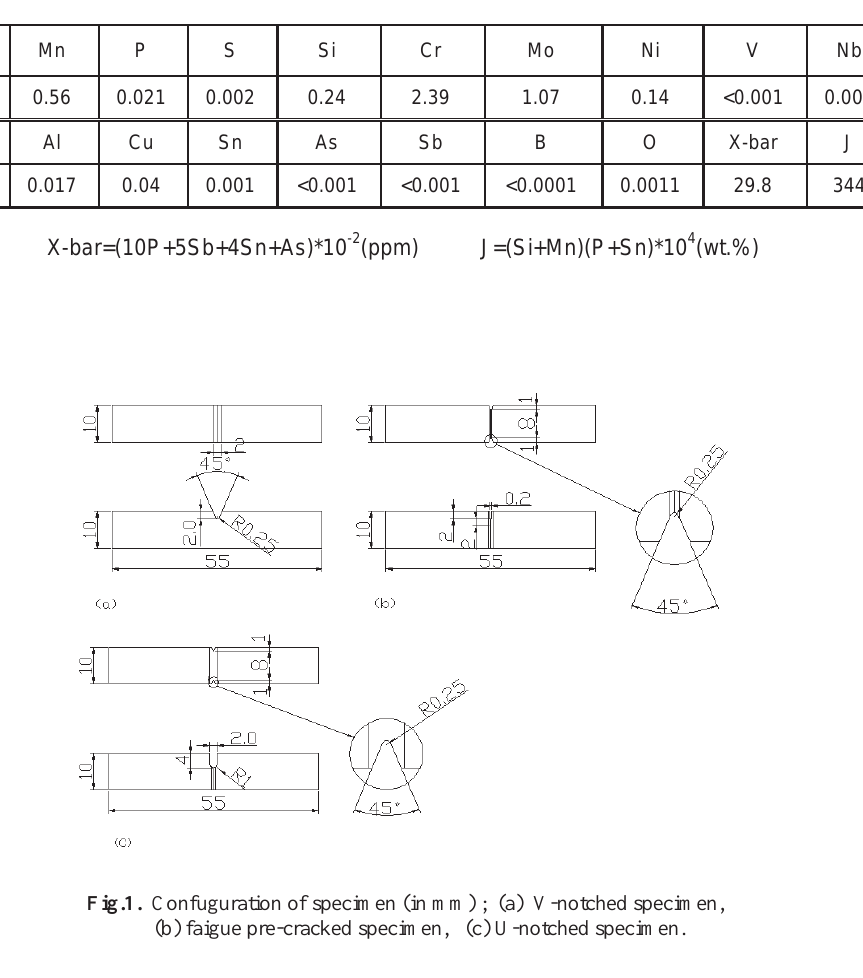
Table 1 Chemical composition of materials (wt. %).